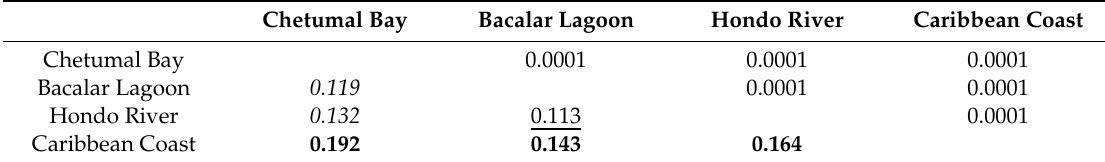
Table 2. Pairwise genetic di ff erentiation values ( Φ PT , below the diagonal) determined for Rhizophora mangle among four hydrological systems of the Transverse Coastal Corridor system, southern Quintana Roo, Mexico. Above diagonal: probability for Φ PT based on 9999 permutations. Bold, italics, and underline values represent the hierarchical spatial structure for the genetic di ff